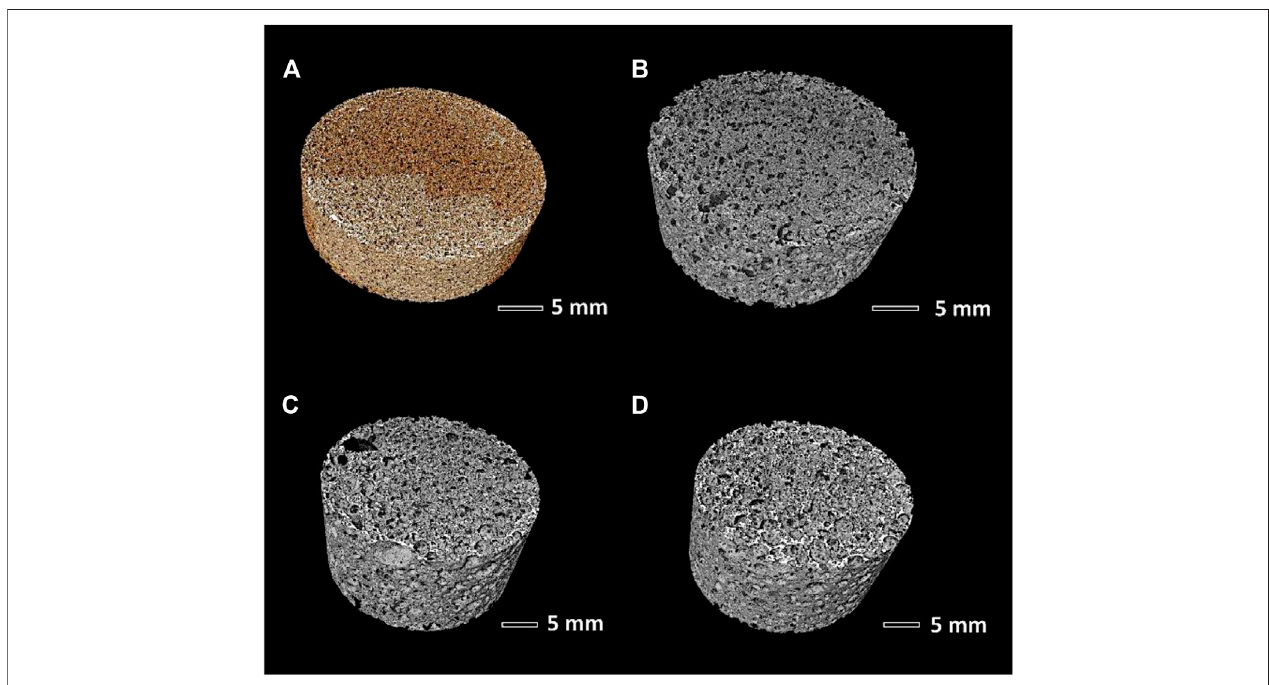
FIGURE 8 | Microtomography reconstructed images: (A) sample A (Biosilicate ® glass-ceramics); (B – D) samples B, C, and D (remelted Biosilicate ® ).